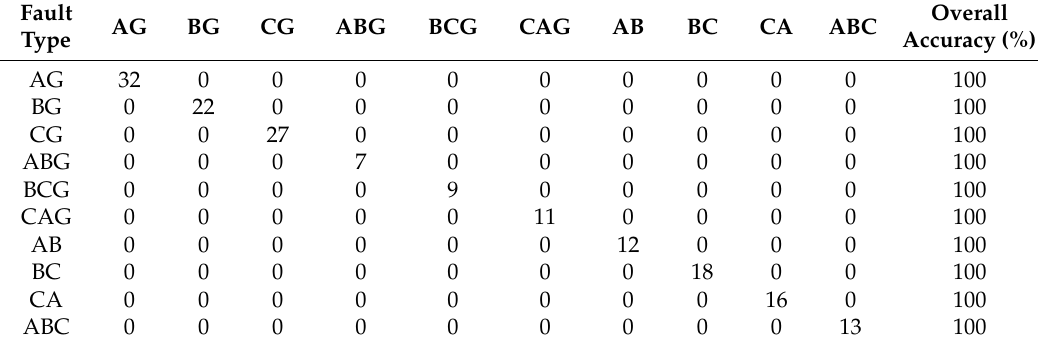
Table 10. Actual short-circuit fault classification